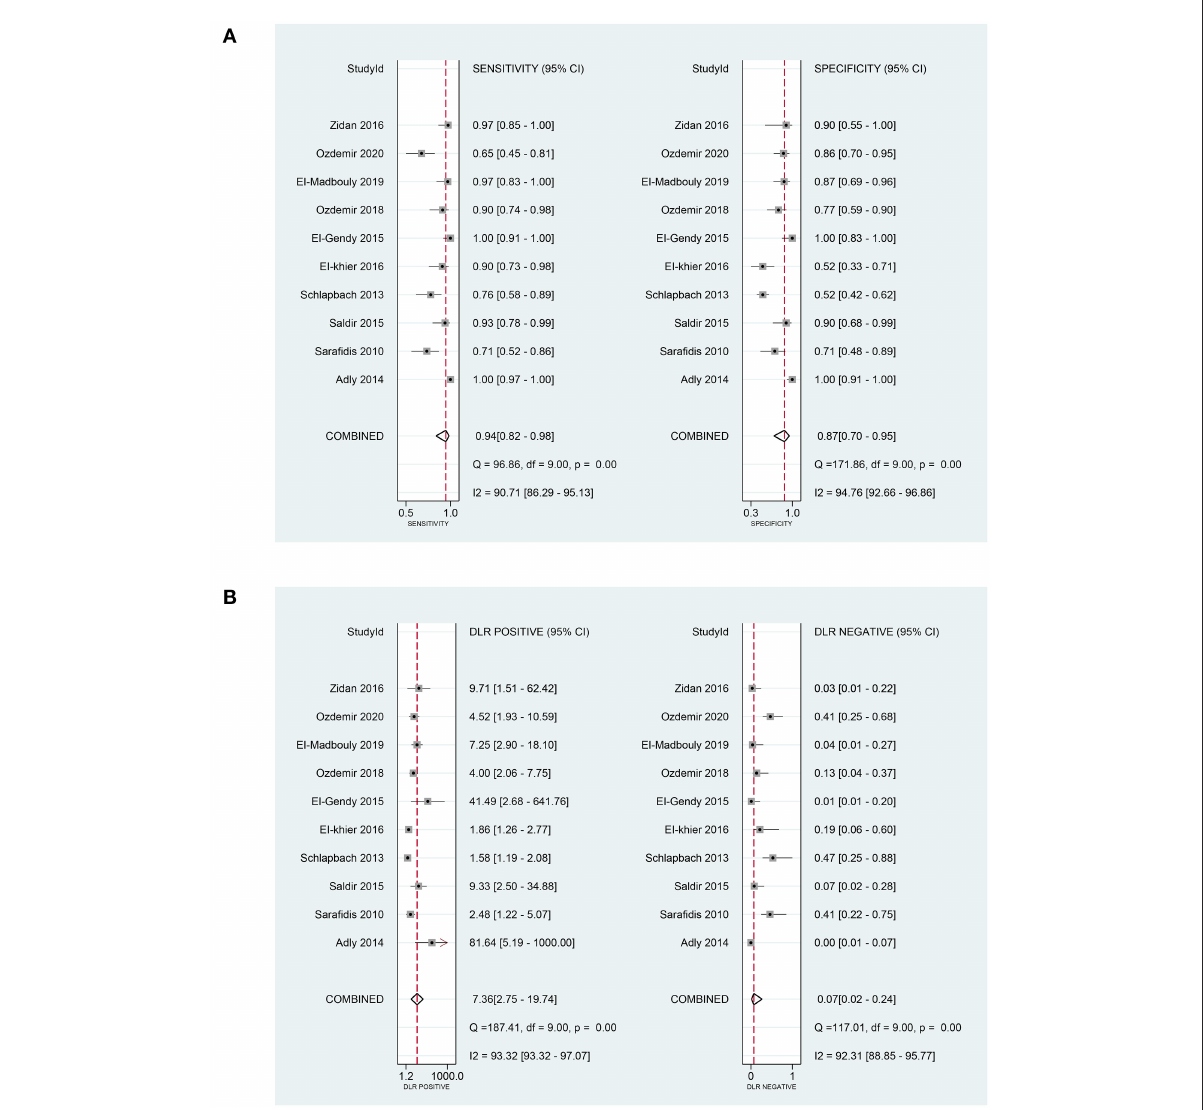
FIGURE3 The pooled sensitivity, specificity, PLR, and NLR of sTREM-1 in diagnosing neonatal sepsis. (A) The pooled sensitivity and specificity. (B) The pooled PLR and NLR. PLR, positive likelihood ratio; NLR, negative likelihood ratio; sTREM-1, soluble triggering receptor expressed on myeloid